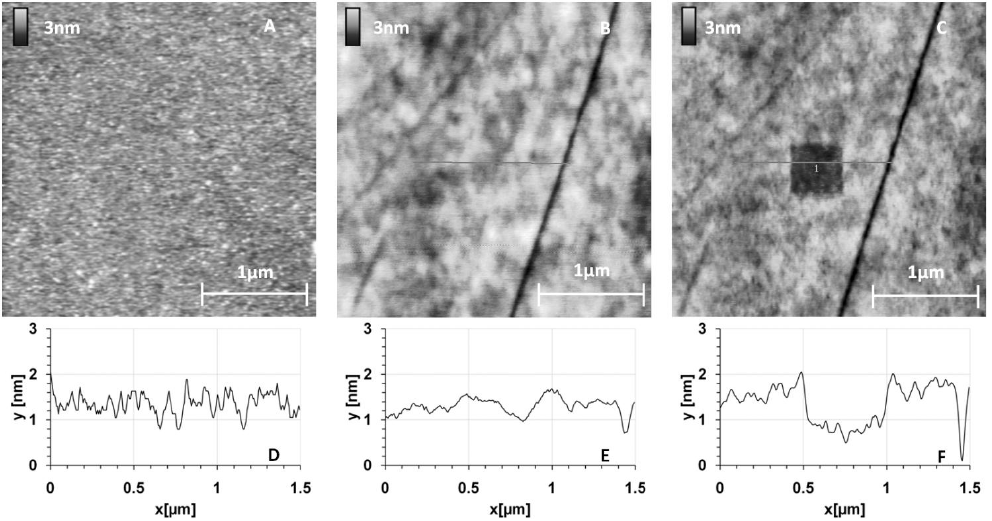
Figure 2. GaAs surface before ( A ) and after ( B , C ) thiolate functionalization (10% MHDA) and their corresponding sections (respectively D , E , F